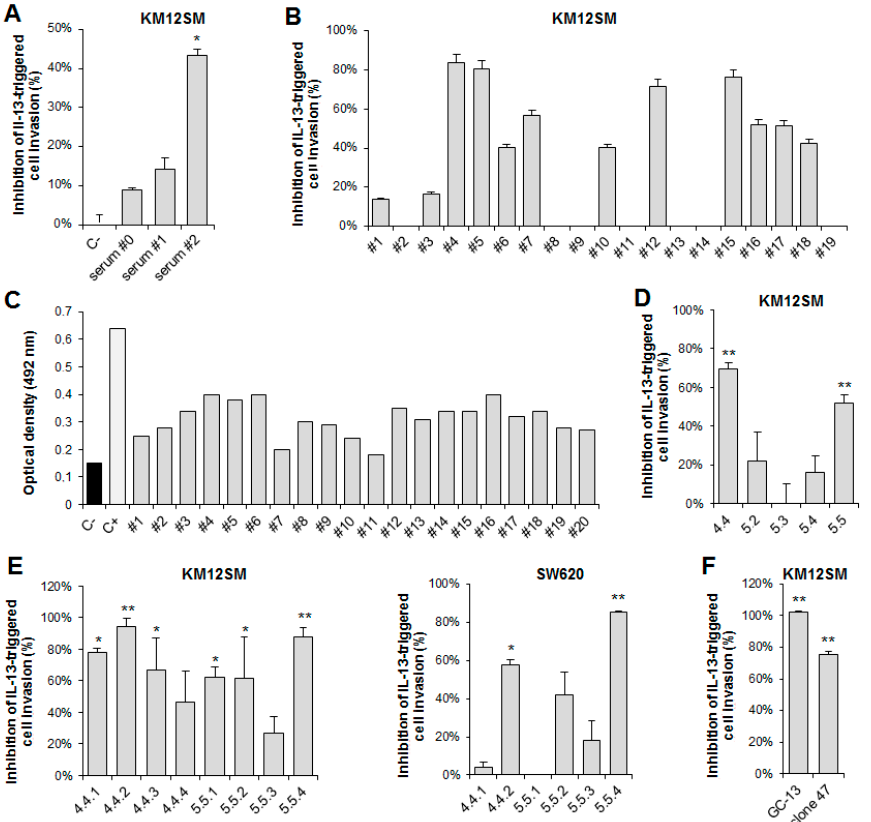
Figure 1. Functional screening and selection of IL13R α 2 D1-specific antibodies to inhibit IL13-promoted cell invasion. For antibody screening, KM12SM cells were subjected to inhibition of cell invasion through Matrigel in the presence of ( A ) the polyclonal serum of each animal and ( B ) supernantants after hybridoma fusion. ( C ) Same supernatants were tested by indirect ELISA against the uncoupled IL13R α 2 peptide. ( D , E ) Preselected clones #4 and #5 and selected subclones were tested in cell invasion inhibition assays either in KM12SM or SW620 cells. ( F ) Cell invasion assays with a chicken antibody (GC-13) prepared against a similar D1 peptide. * p < 0.05; ** p < 0.01.